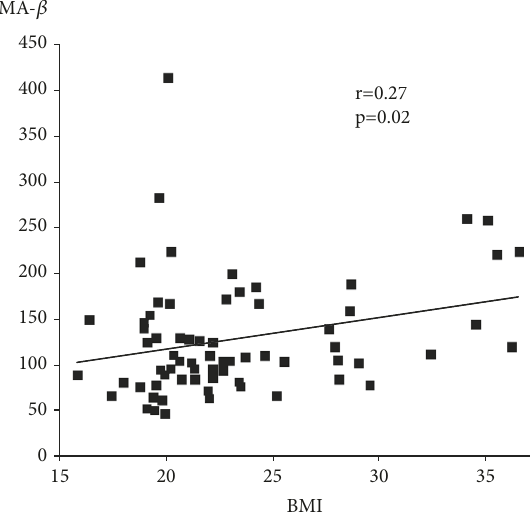
Figure 5: Therelationshipbetween prepregnancyBMI and HOMA- 𝛽 in GDM women. HOMA- 𝛽 : Homeostasis model assessment of 𝛽 - cell function, GDM: gestational diabetes mellitus. A positive linear correlation was found between the BMI and HOMA- 𝛽 with respect to